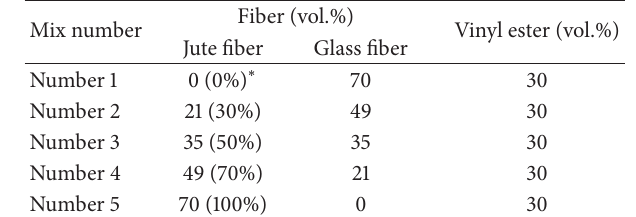
Table 2: Mixture ratio of HGJFRP composite bar.